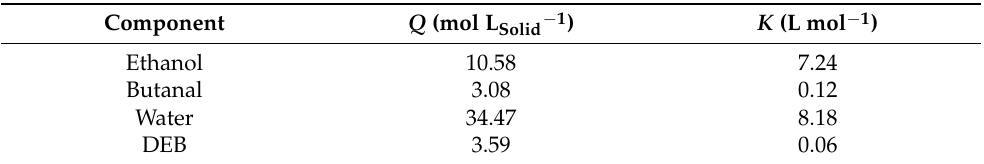
Table 1. Multicomponent Langmuir isotherm parameters for the species involved in the synthesis of 1,1-diethoxybutane (DEB) at 303 K [22].